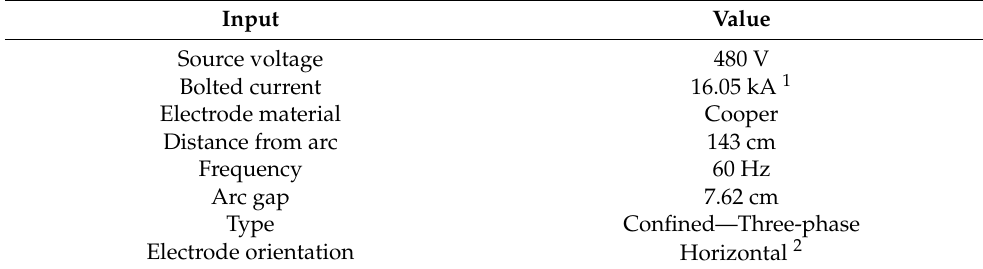
Figure 13. Data input screen for ArcPro simulation—Case study 5. Table 10. Relation of input data for ArcPro simulation—Case study 5.